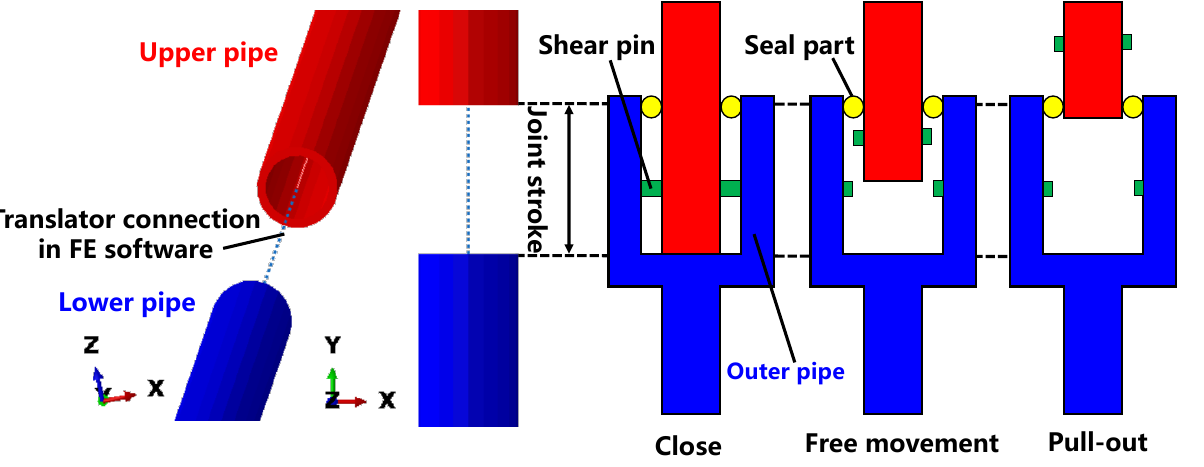
Figure 7. The working mechanism of the expansion joint and its implementation in FEM.